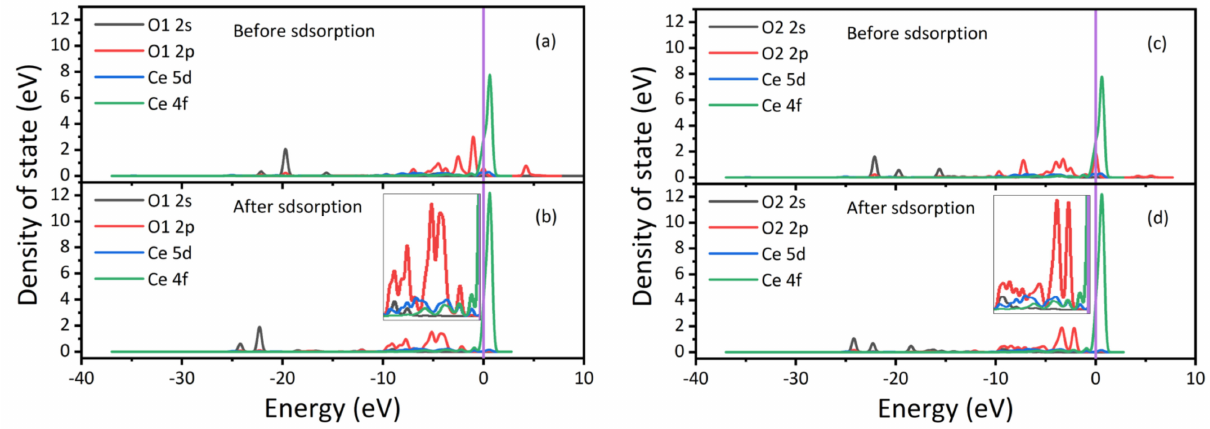
Figure 4. PDOS plots for O and Ce ( a , c ) before and ( b , d ) after the adsorption of NHA on the bastnaesite (100) surface.